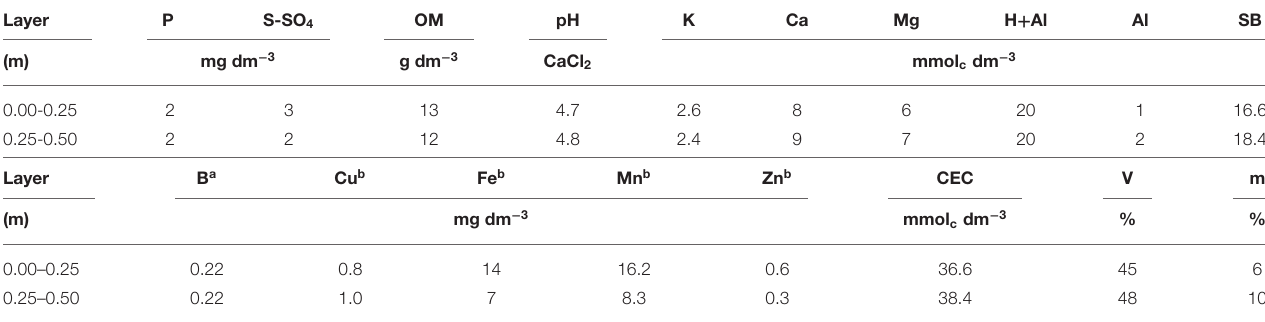
TABLE 1 | Pre-experiment soil chemical characterizations in the soil layers of 0.00–0.25 and 0.25–0.50m. Layer